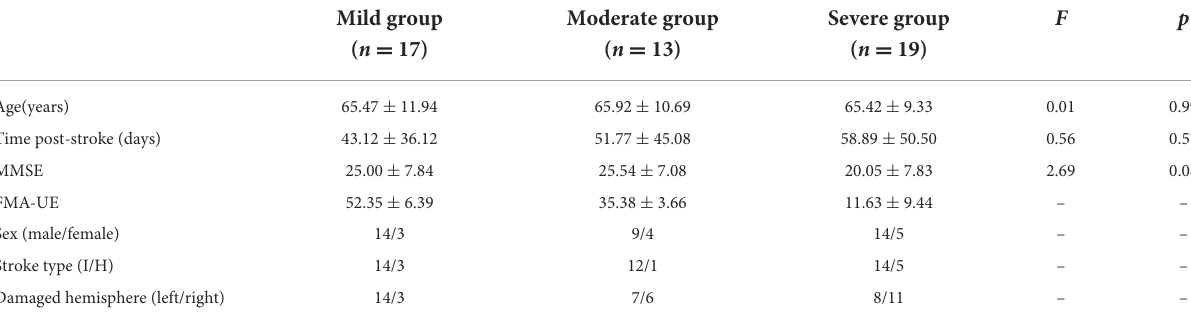
TABLE 1 Demographic and clinical data of stroke